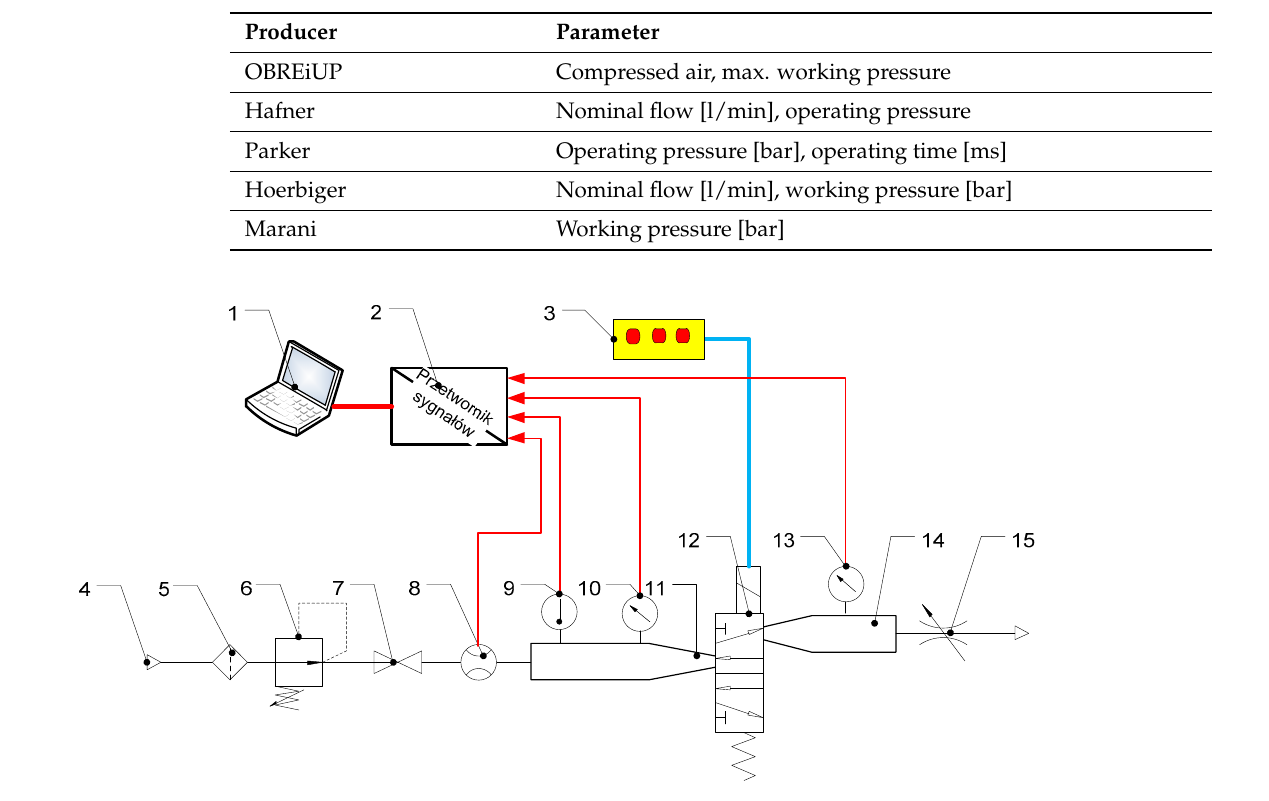
Figure 5. Stand for testing flow parameters of pneumatic elements: 1—control panel, 2—tested man ‐ ifold, 3—pressure sensor, 4—laboratory power supply, 5—measuring pipe, 6—cut ‐ off valve, 7— computer, 8—flowmeter, 9—signal and power cables, 10—control panel, 11—pneumatic tube, 12— compressor.